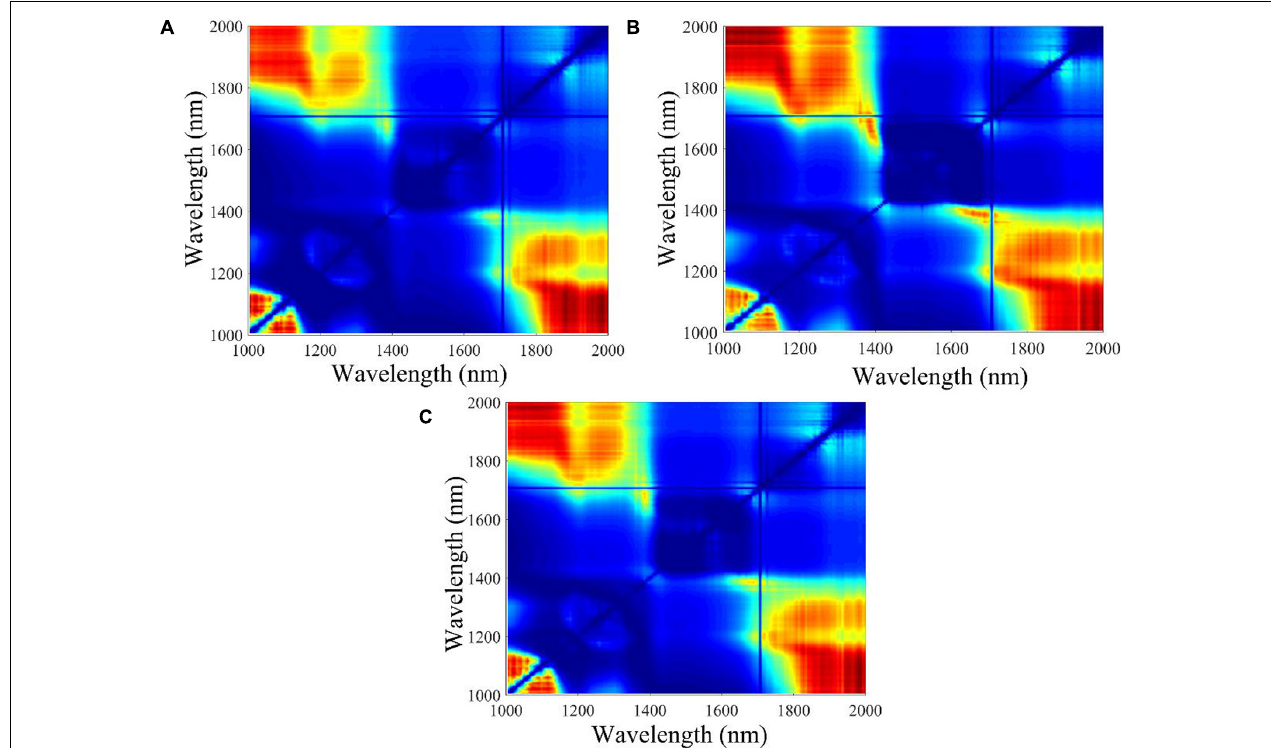
FIGURE 3 | The contour plots of F-value calculated from different waveband ratio combinations. The color change from blue to red represents the F-value increases from low to high. (A) Embryo side, (B) endosperm side, and (C) both sides.